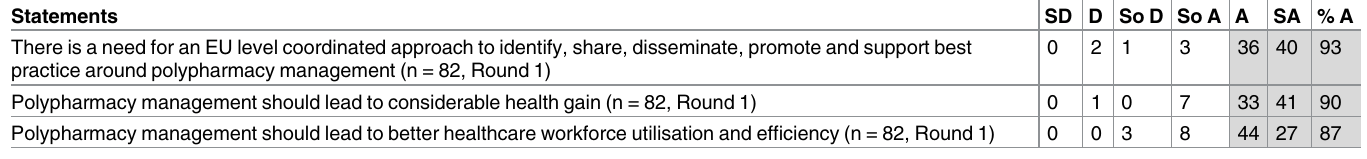
Table 3. Number of responses and % agreement(strongly agree/agree) to statements relating to potential gain arising from polypharmacy management.